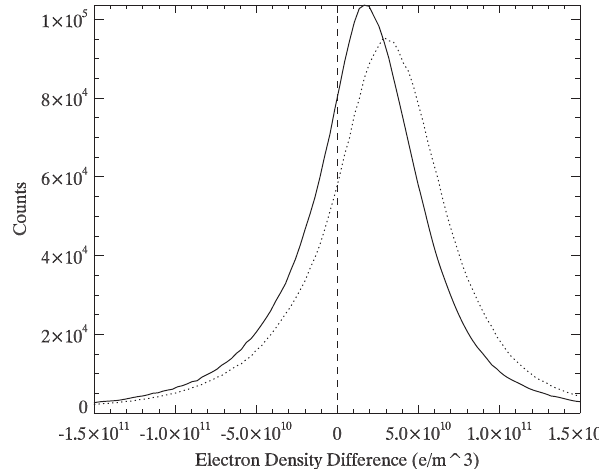
Fig. 12. Probability distributions of electron density errors for the IRI (dotted lines) and E-CHAIM (solid lines) with respect to CHAMP in situ electron density